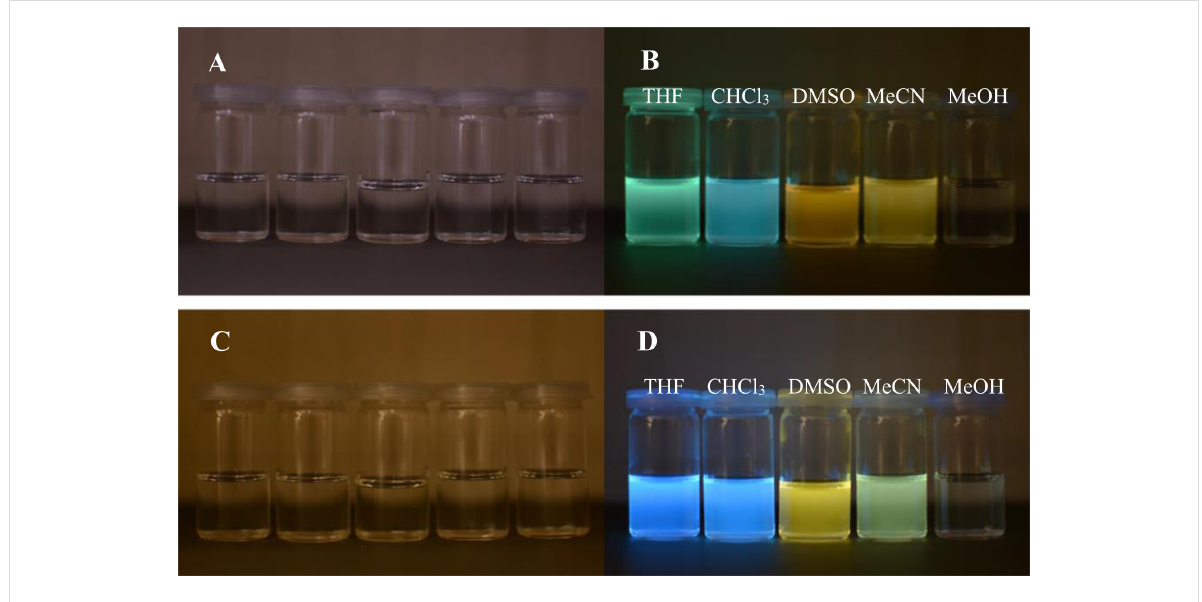
Figure 5: Photos of compound 8c (A and B) and compound 11c (C and D) in THF, CHCl 3 , DMSO, MeCN and MeOH before excitation (A and C) and under excitation (B and D) of UV (366 nm).